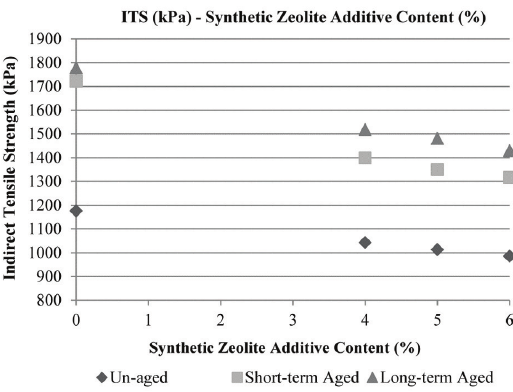
Figure 4. ITS results corresponding additive contents for synthetic zeolite modified mixtures.